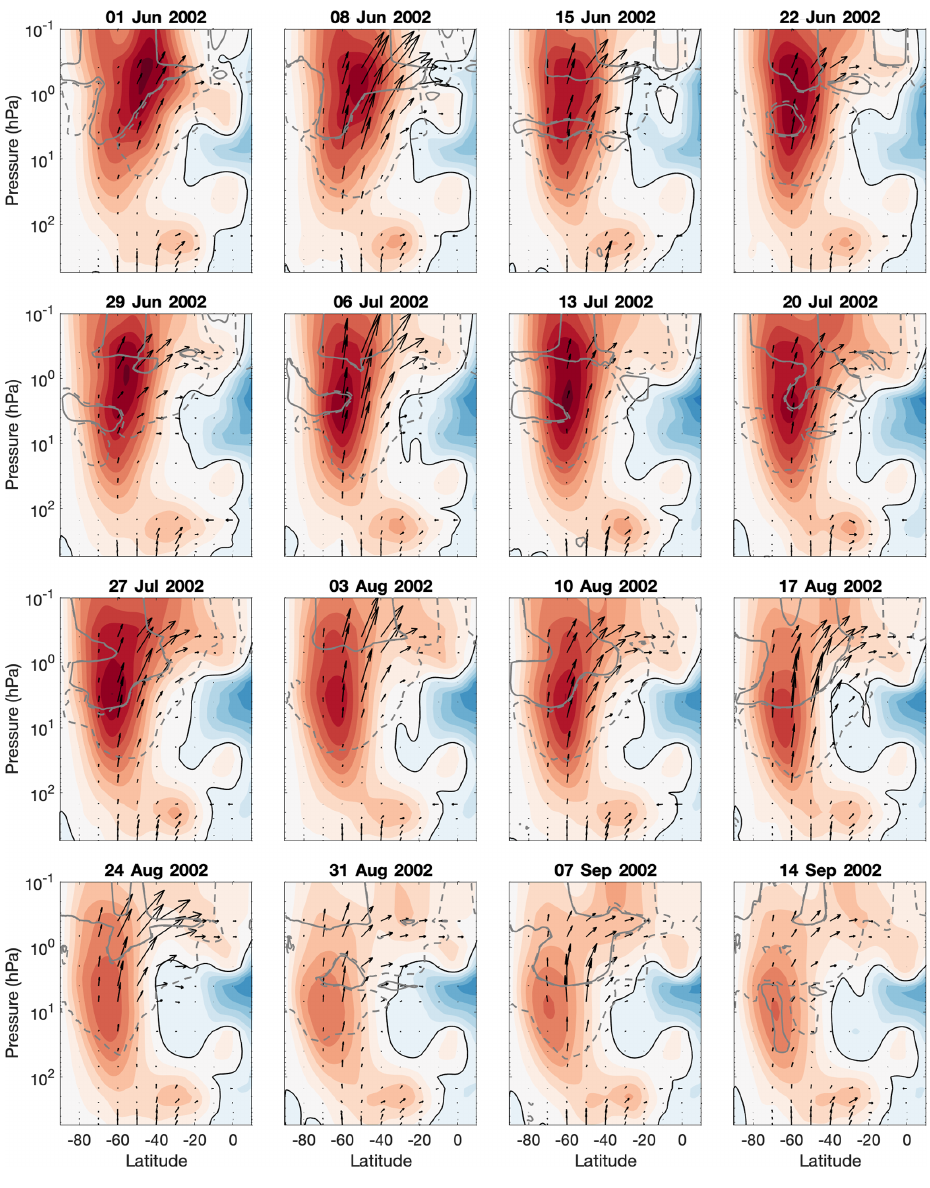
Figure 4. The same as Fig. 1 but for the year